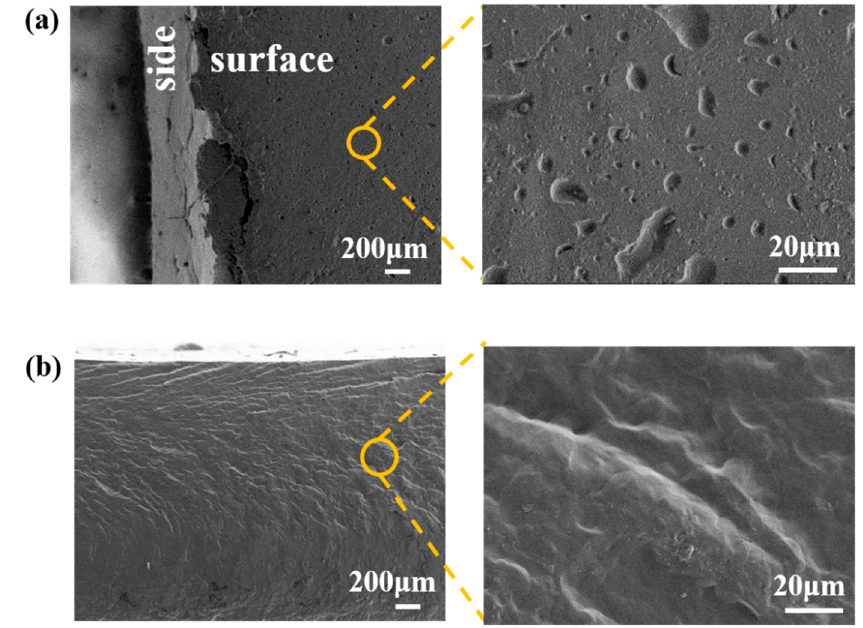
Figure 4. SEM morphology of PS14-PEG XH sample: ( a ) surface; ( b ) fracture.